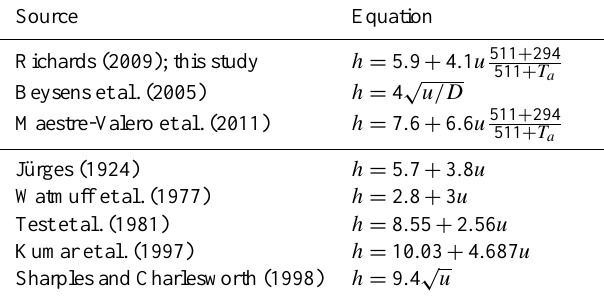
Table 3. A selection of the various parameterizations for the heat transfer coefficient found in the literature. The first three are studies on dew formation. Here, u and T a are the horizontal wind speed and air temperature at 2m height, and D is the characteristic length of the condenser (e.g.